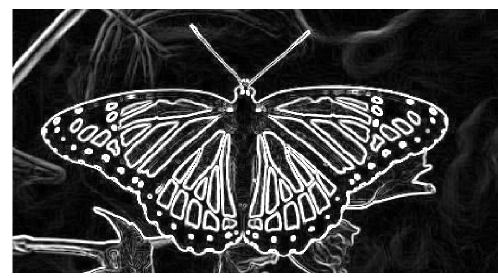
Figure 6. MATLAB result of Sobel Operator.